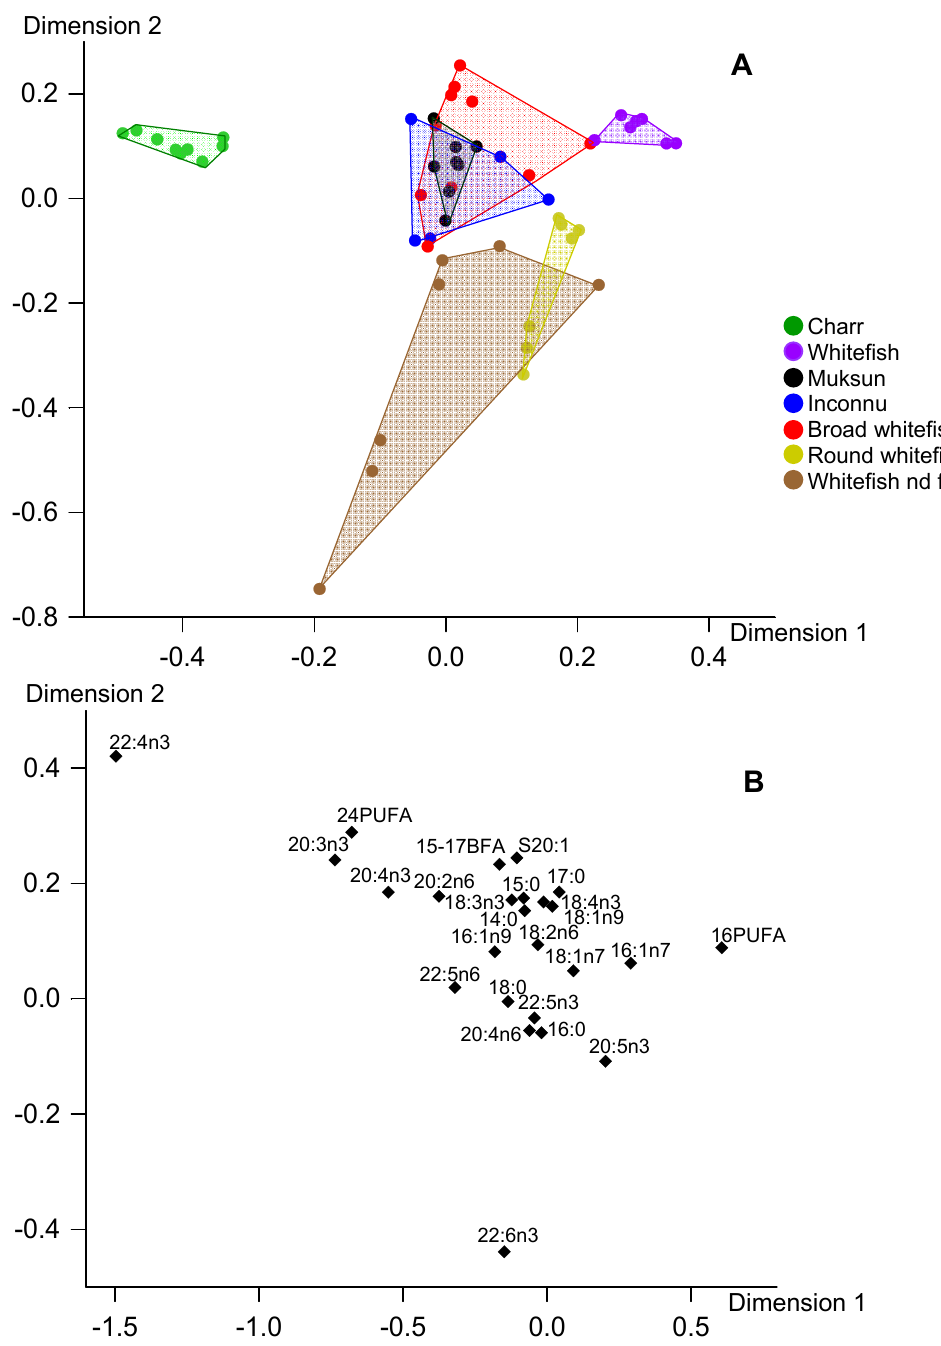
Figure 1. Canonical correspondence analysis of fatty acid percentages (% of FA sum) in total lipids of muscles of seven fish species from arctic lakes (Siberia, Russia). A —individual variables, B —factor structure coefficients for fatty acids. Dimension 1 and Dimension 2 represented 33.9% and 21.2% of inertia, respectively.